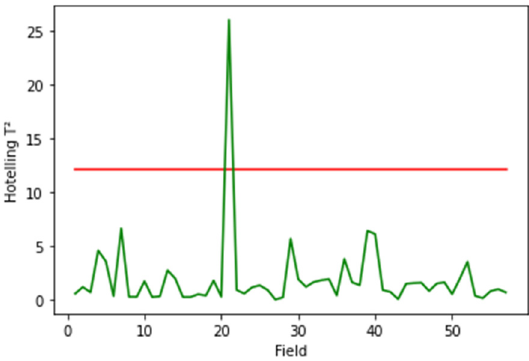
Figure 13. The Hotelling T 2 chart for simultaneous screening model A for immiscible CO 2 -EOR.